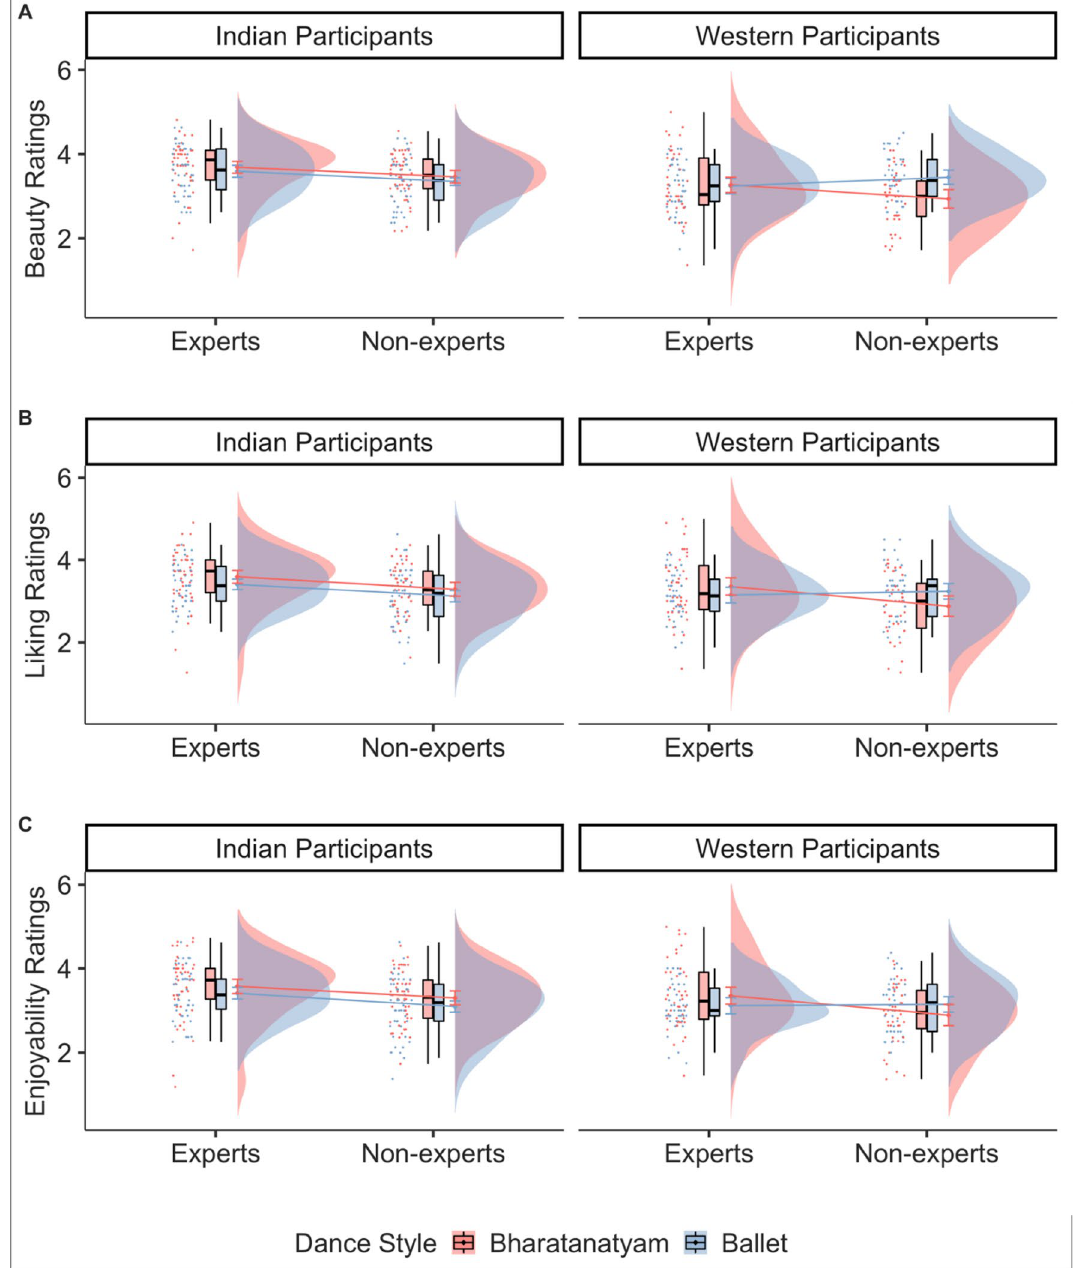
Figure 12. The effect of dance style (Bharatanatyam or ballet depicted in red and blue respectively), expertise (art experts or non-experts) and culture (Indian participants or Western participants) on the ratings of beauty ( A ), liking ( B ), and ( C )